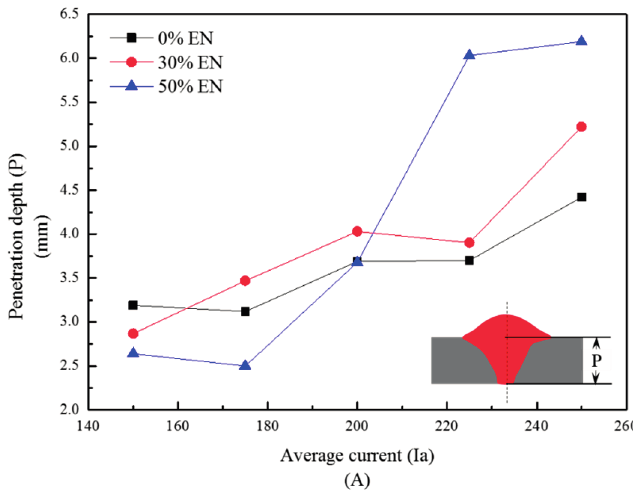
Figure 7. Comparison of penetration depth ( P ) at different EN ratio and Ia.